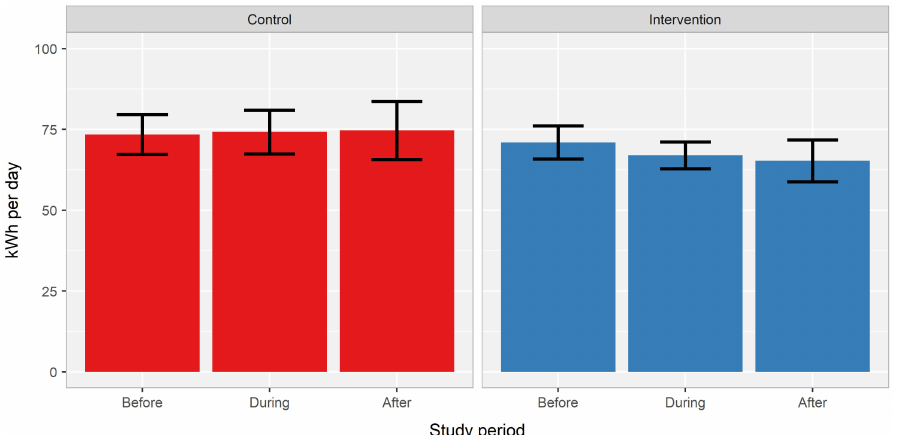
Figure 5. Combined electricity consumption per day (kWh/day) for lighting and small power, comparing the control and intervention study groups for the study periods before (1 September– 31 October 2017), during (1 November 2017–31 January 2018) and after (1 February–30 April 2018) the behavior change intervention. 1 Standard Deviation of the mean is